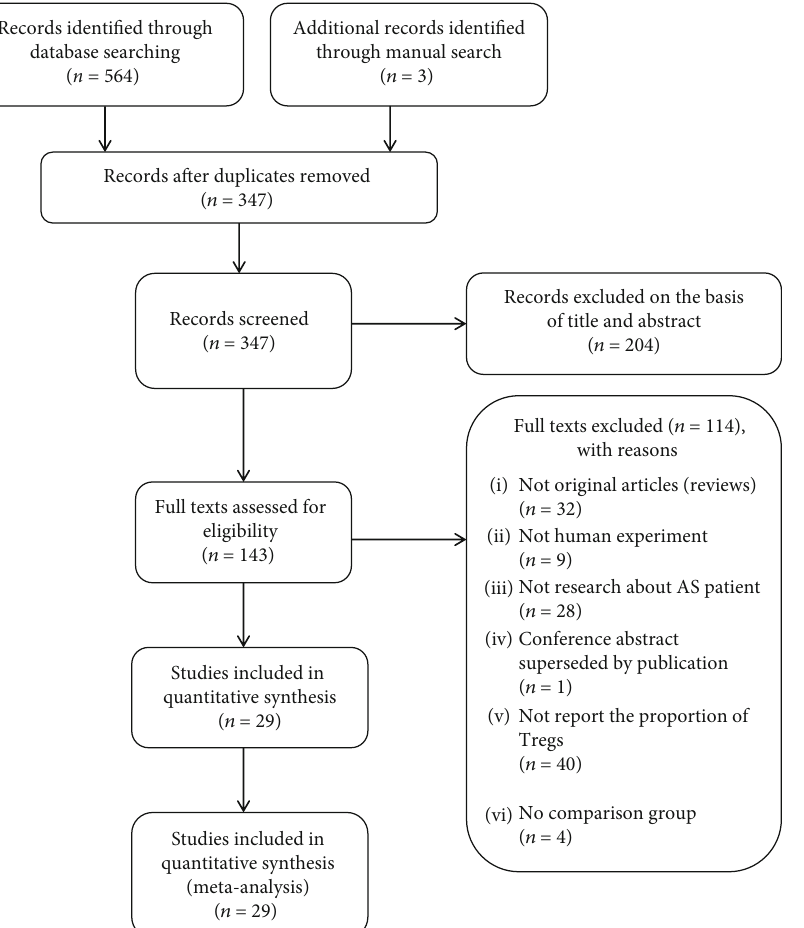
Figure 1: The study selection